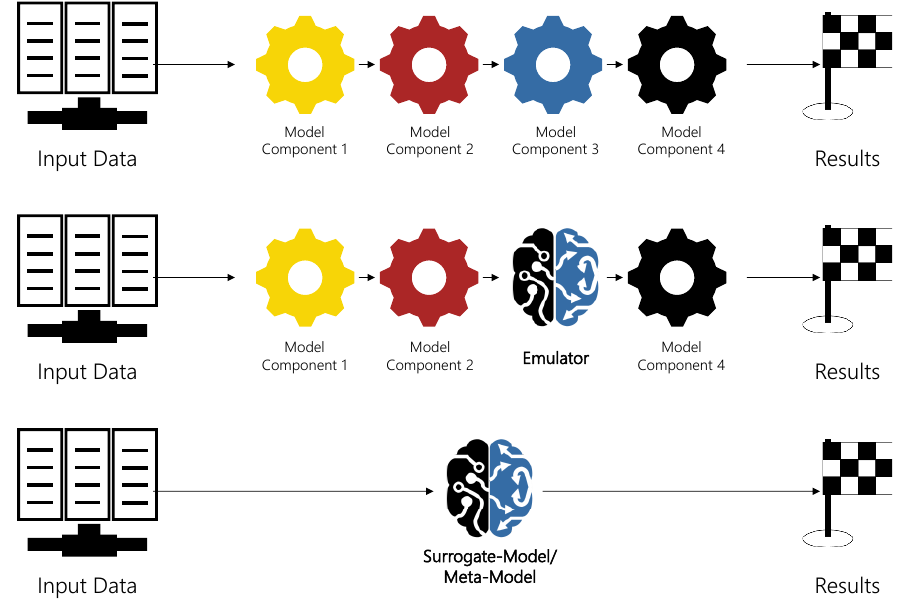
Figure 1. Schematic illustration of (hybrid) simulation, emulation, and surrogate/meta-models. An advantage of emulation over surrogate- or meta-models is the reduced functional relationship, because only a fraction of the complexity is covered by an ML